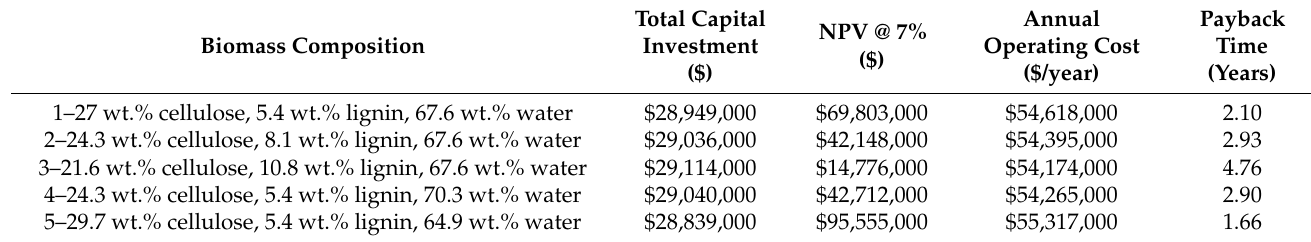
Table 14. The effects of biomass composition on process economics. Biomass Composition